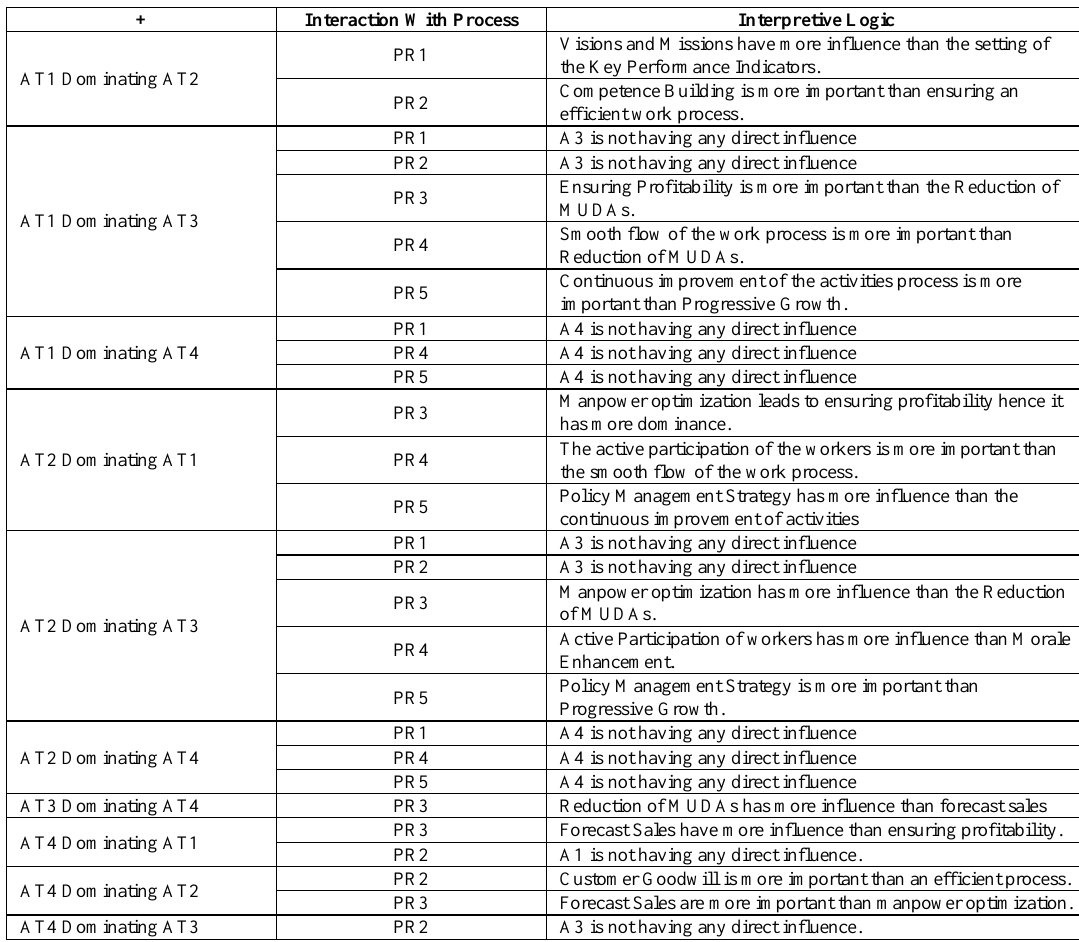
Table 14. Knowledge base ranking of actors and